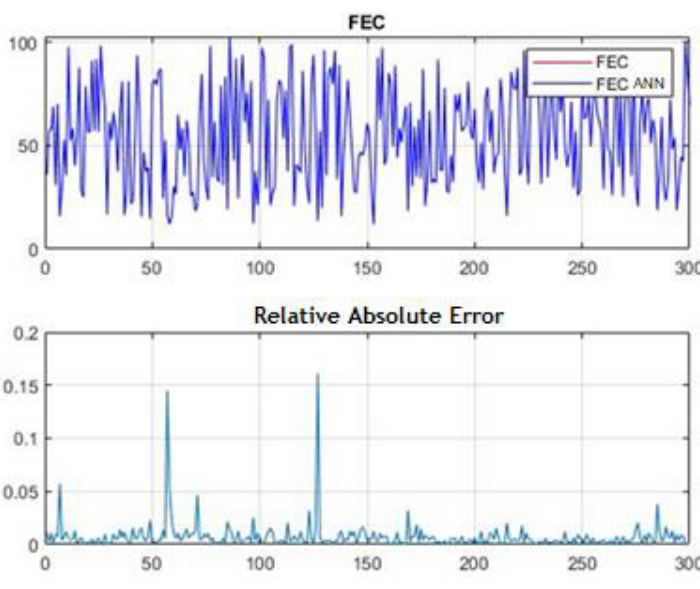
Figure 5. ANN FEC model output.